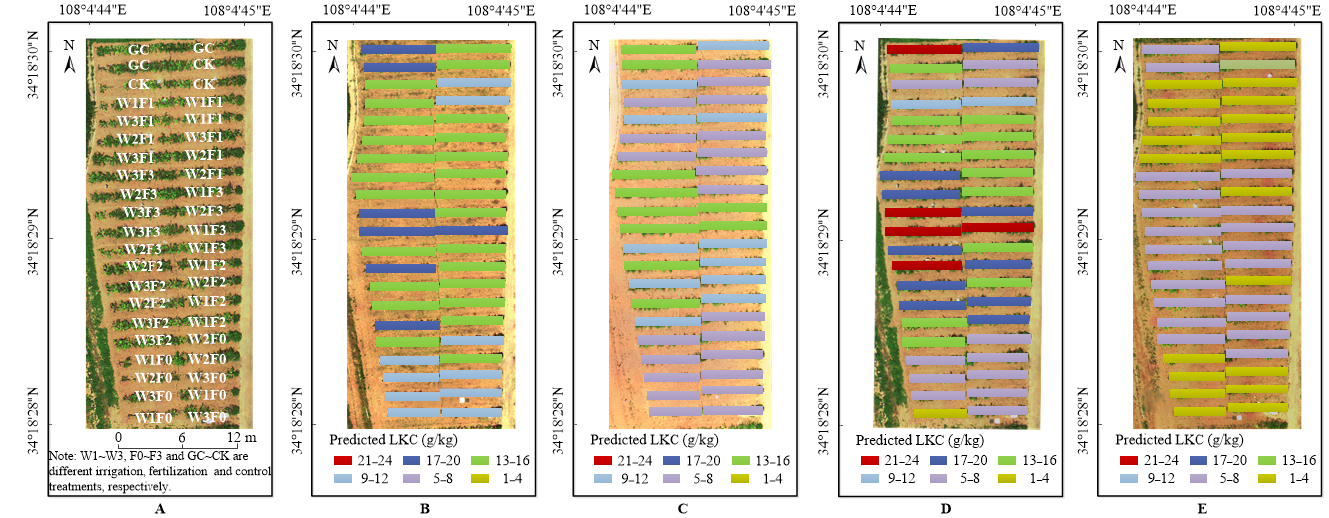
Figure 7. ( A ) Distribution map of grape with different treatments based on UAV image (22 June